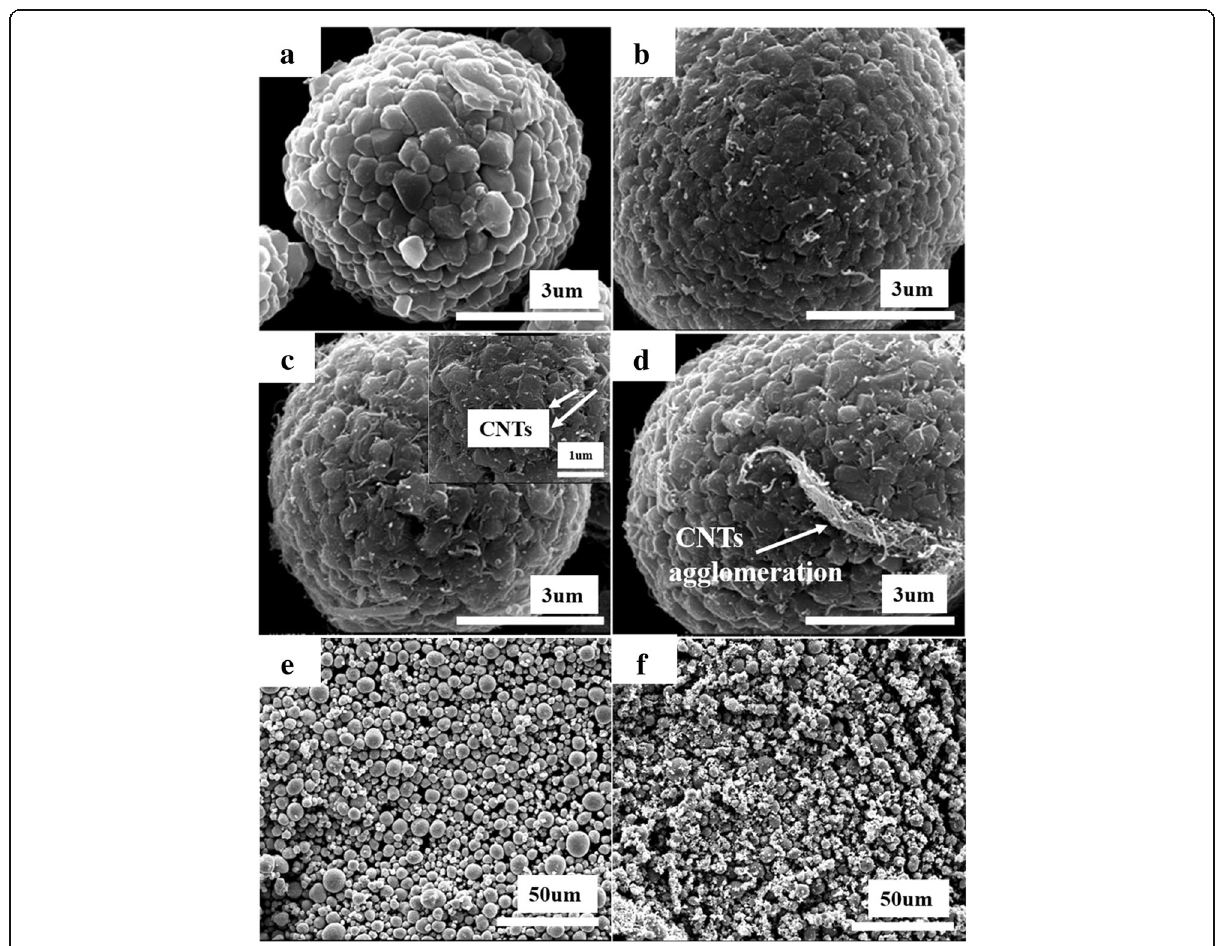
Fig. 1 SEM images of a pristine NCA and b 5 wt% CNT, c 10 wt% CNT, d 20 wt% CNT-composited NCA. SEM images of pristine NCA e ground in agate mortar for 1 h and f ball-milled at 100 rpm for 1